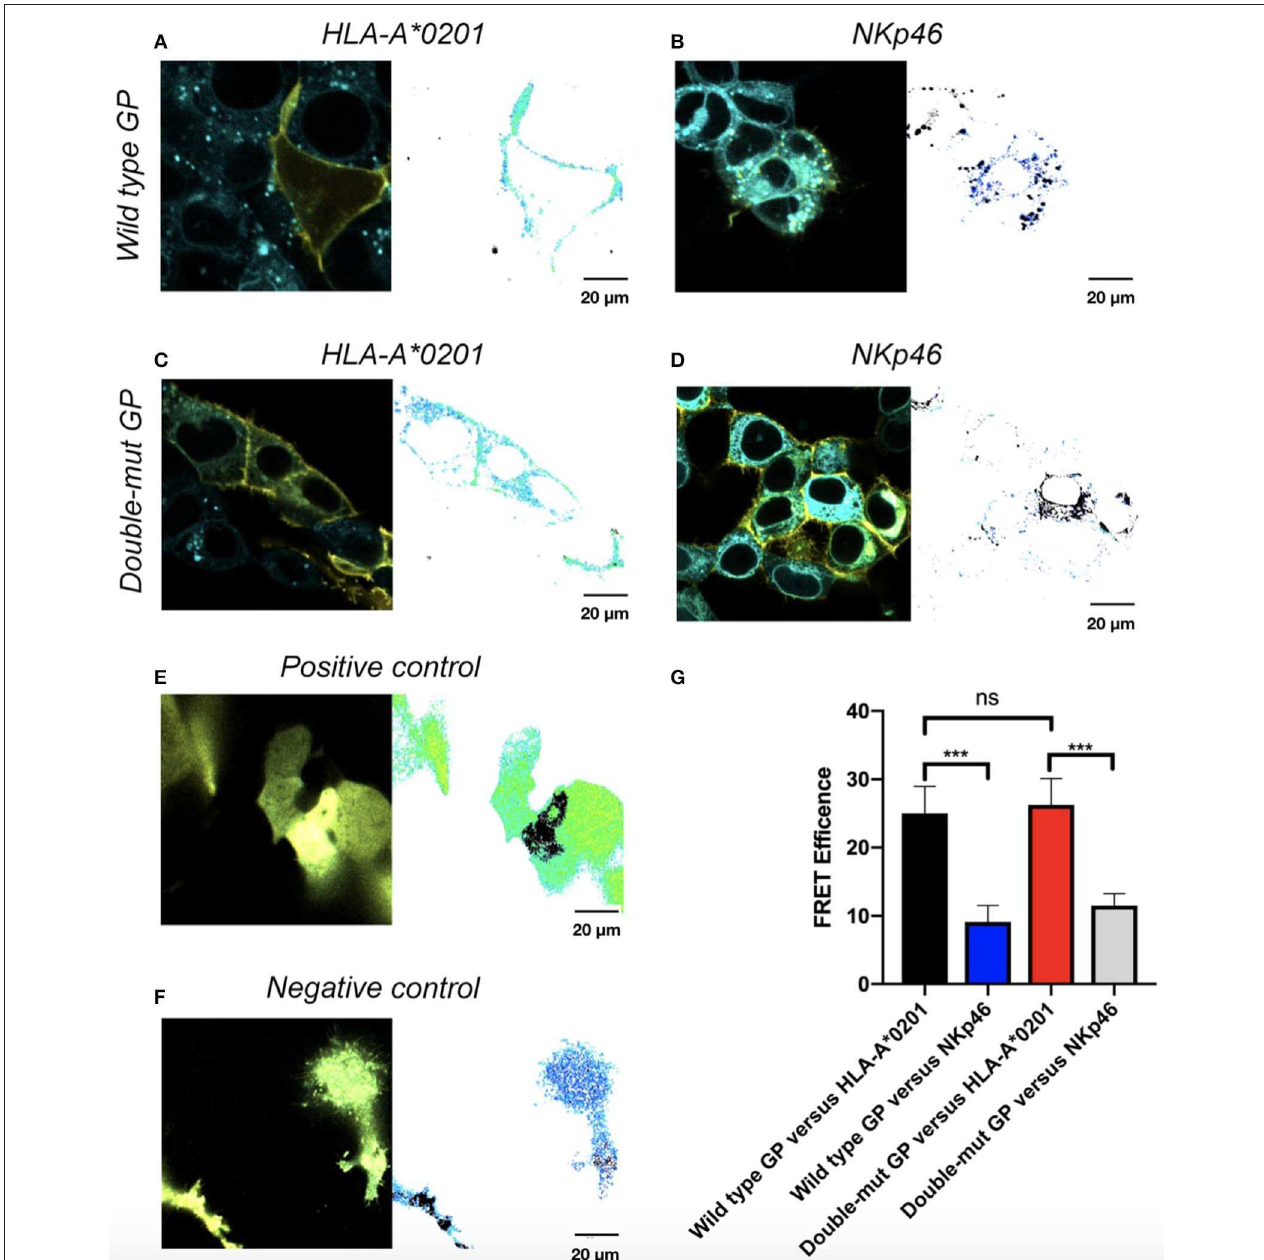
FIGURE 4 | Site-specific mutations, disrupting the N-linked glycosylations in GP, do not affect co-localization of GP with HLA-A*0201. Cells were stably transfected with either CFP-fused HLA-A*0201 (A,C) or CFP-fused NKp46 (B,D) and then transiently transfected with either YFP-fused wild type GP (A,B) or YFP-fused double mutant GP (C,D) . Thirty hours post transfection, cells were assayed by confocal microscopy using a 40 × /1.3 UPLSAPO objective (magnification including ocular lens is 400 × ). Summary plot shows FRET efficiency in various samples. Results are representative images from 50 images taken from the experiment. Scale bar (20 µ m) is shown at the bottom right corner of each plot. (E) Positive control, (F) Negative control, (G) Summary results. Graphs represent mean ± SEM. *** p < 0.001, ordinary one-way ANOVA multiple comparisons test.